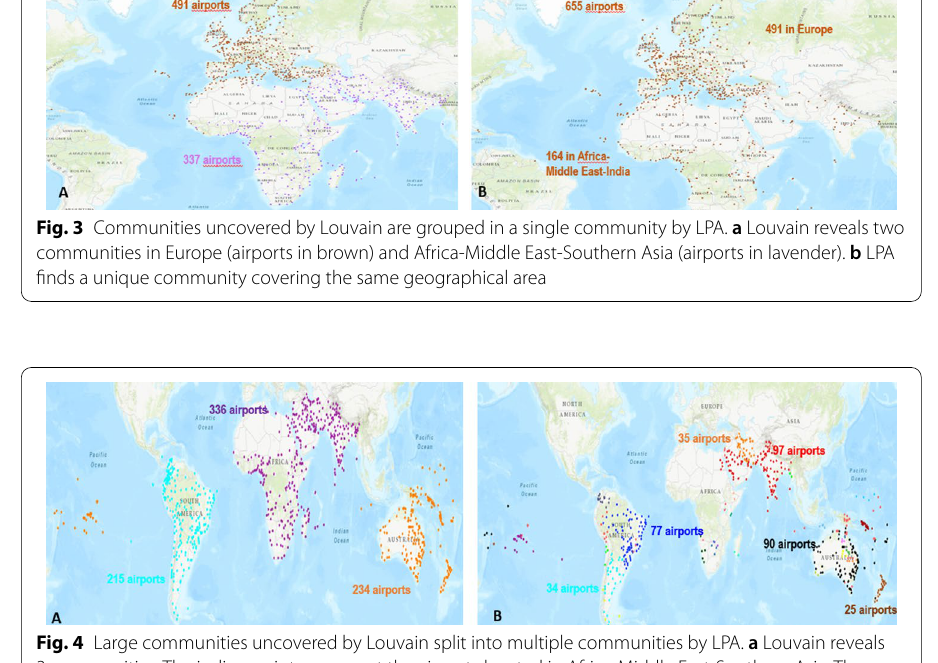
with the same colors. They are located respectively in North and Central America- Caribbean, East and Southeast Asia, and Russia-Central Asia-Transcaucasia. The fourth large community uncovered by LPA regroup into a single community, airports belonging to different communities uncovered by Louvain. Figure 3 illustrates this behavior. Indeed, parts of European (brown color) and Africa-Middle East-Southern Asia (lavender color) communities uncovered by Louvain merge in the same com- munity (brown color) with LPA. Finally, the three other large communities uncovered by Louvain (Africa-Middle East India, South America, Oceania) split into multiple communities covering smaller geographical areas with LPA. Figure 4 illustrates this behavior. For example, LPA divides into 28 communities the South America (orange color) community of Louvain.